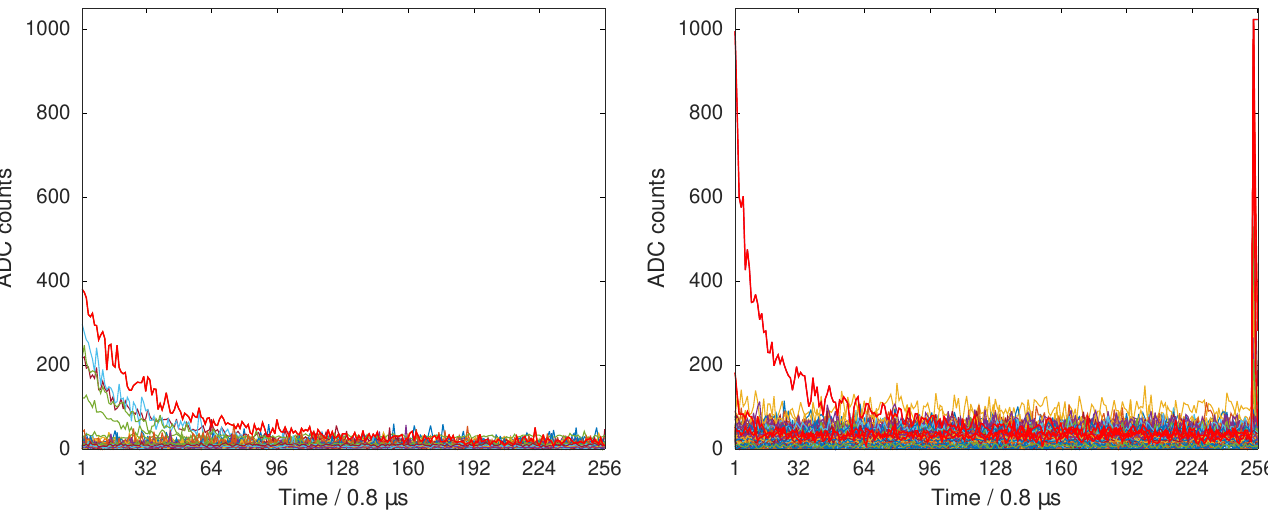
Figure 13. Peculiar waveforms of some TLFs. Left: a “tail” of a TLF suppressed by the anti-trigger introduced in late April 2017. Right: waveforms of a TLF with a mistakenly placed beginning of the record due a bug in the onboard